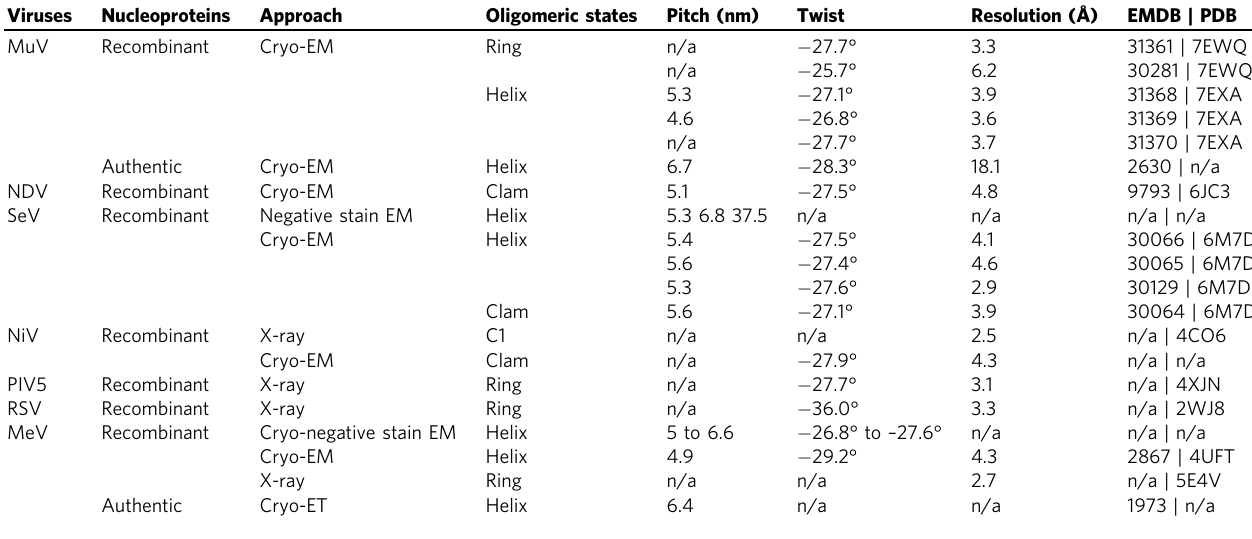
Table 2 Structural parameters of nucleocapsids in the order of Mononegavirales .